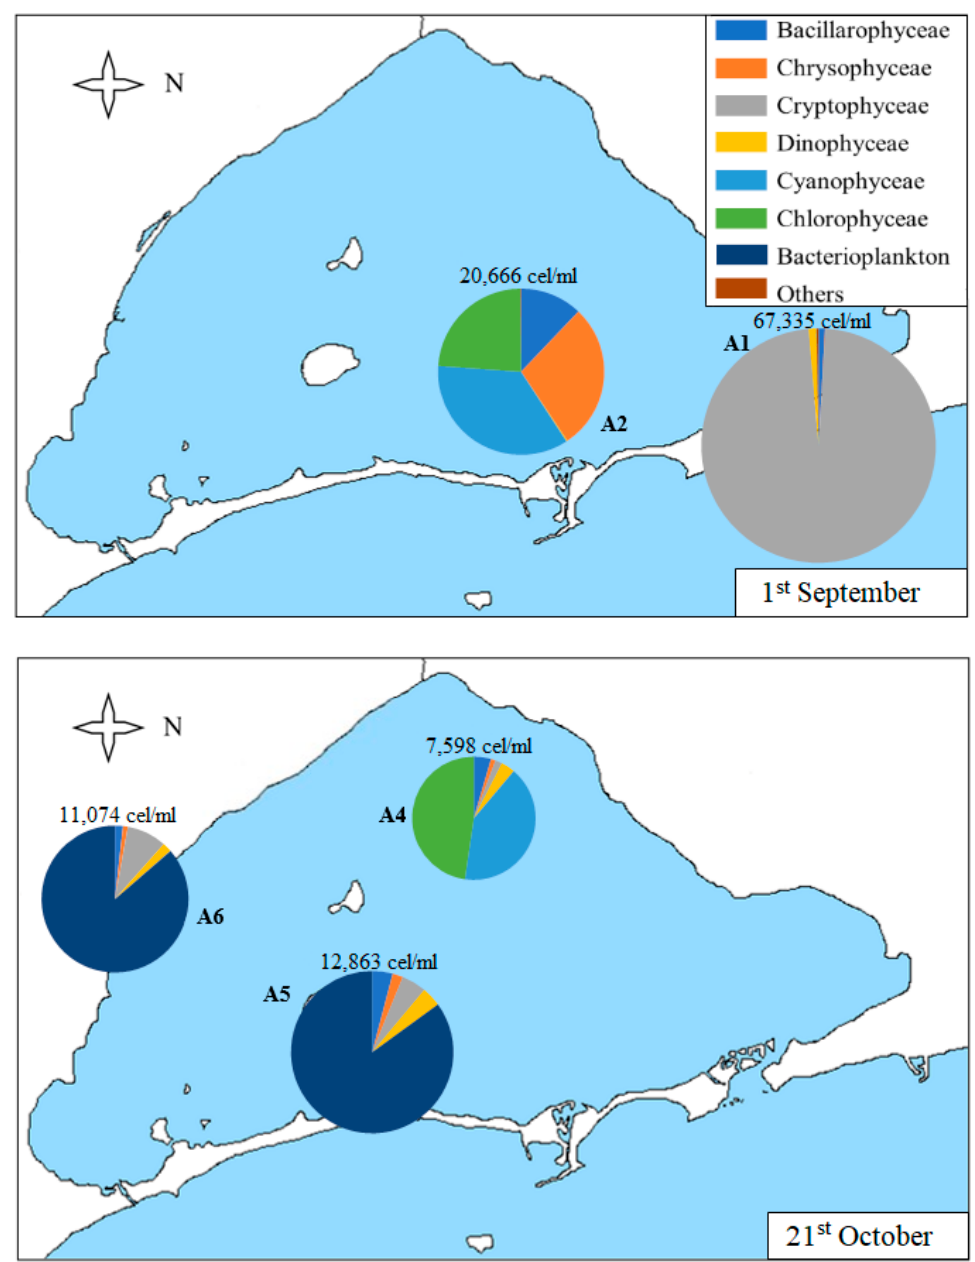
Figure 6. Map of the Mar Menor lagoon with the density graphs of the different classes of phytoplankton found in each sample on 1st September and 21st October. The total density of the sample is annotated on each graph.